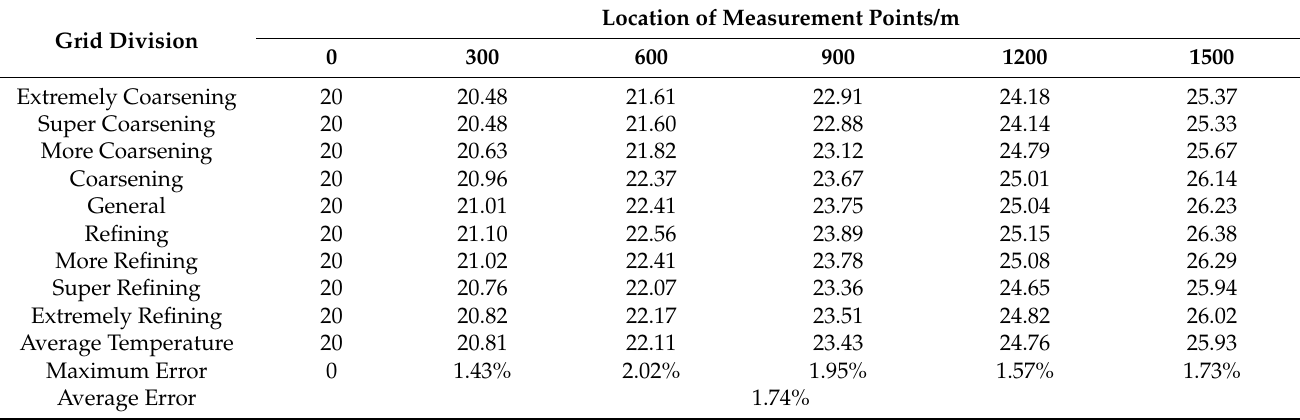
Table 2. Error analysis of each measurement point after gradual encryption of the model grid.